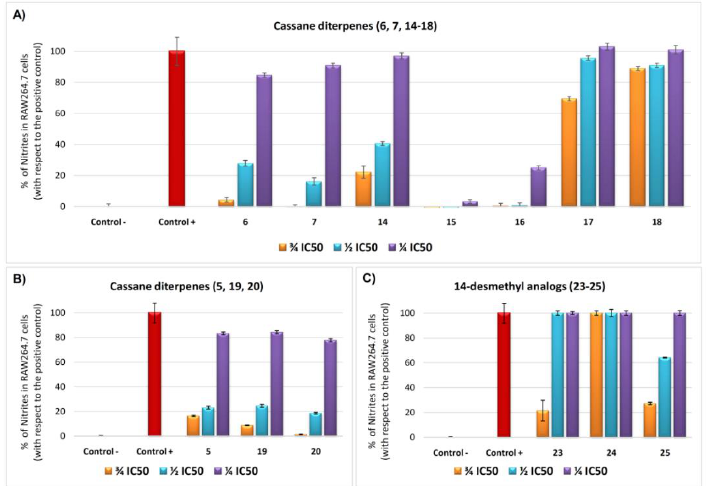
Figure 2. ( A ) The effect of cassane diterpenes ( 6 , 7, and 14 – 18 ). ( B ) Cassane diterpenes ( 5 , 19 , and 20 ). ( C ) their 14-desmethyl analogs 23 – 25 , the release of nitrite assay in LPS activated RAW 264.7 macrophage murine cells at ¼ IC 50 (purple bars), ½ IC 50 (blue bars), and ¾ IC 50 (orange bars) concentrations, after 72. Data represent the mean ± S.D. of at least two independent experiments performed in